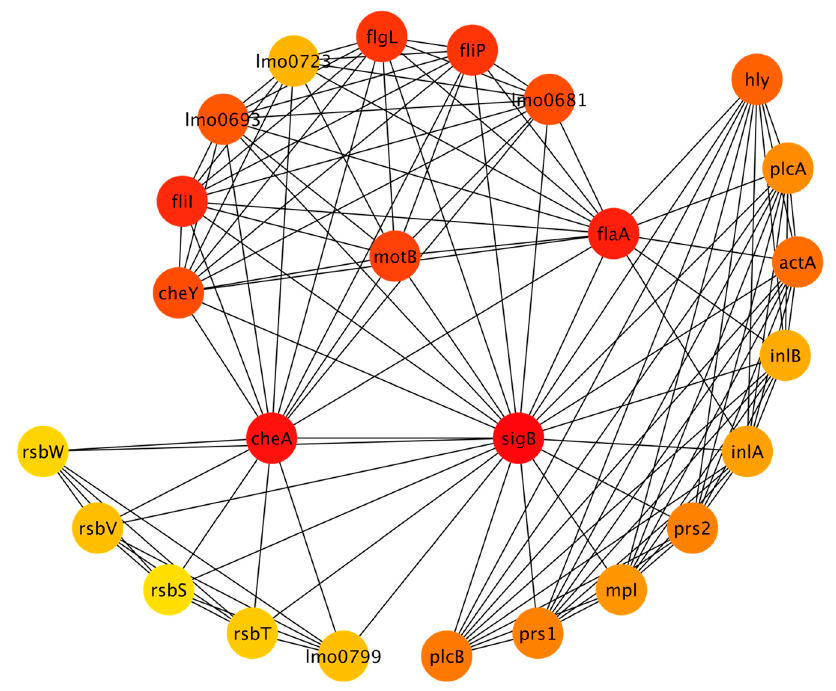
Figure 3. Virulence network depicting top 25 nodes (refer to Table S2 for additional information about each